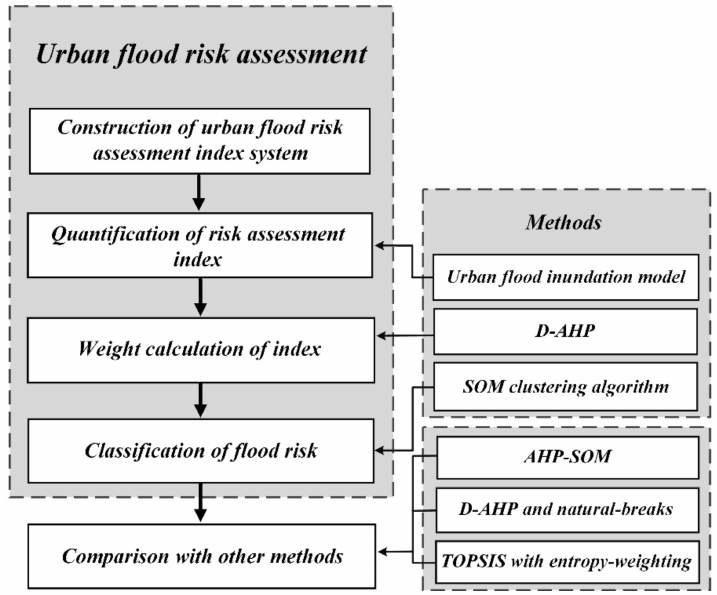
Figure 2. Research framework